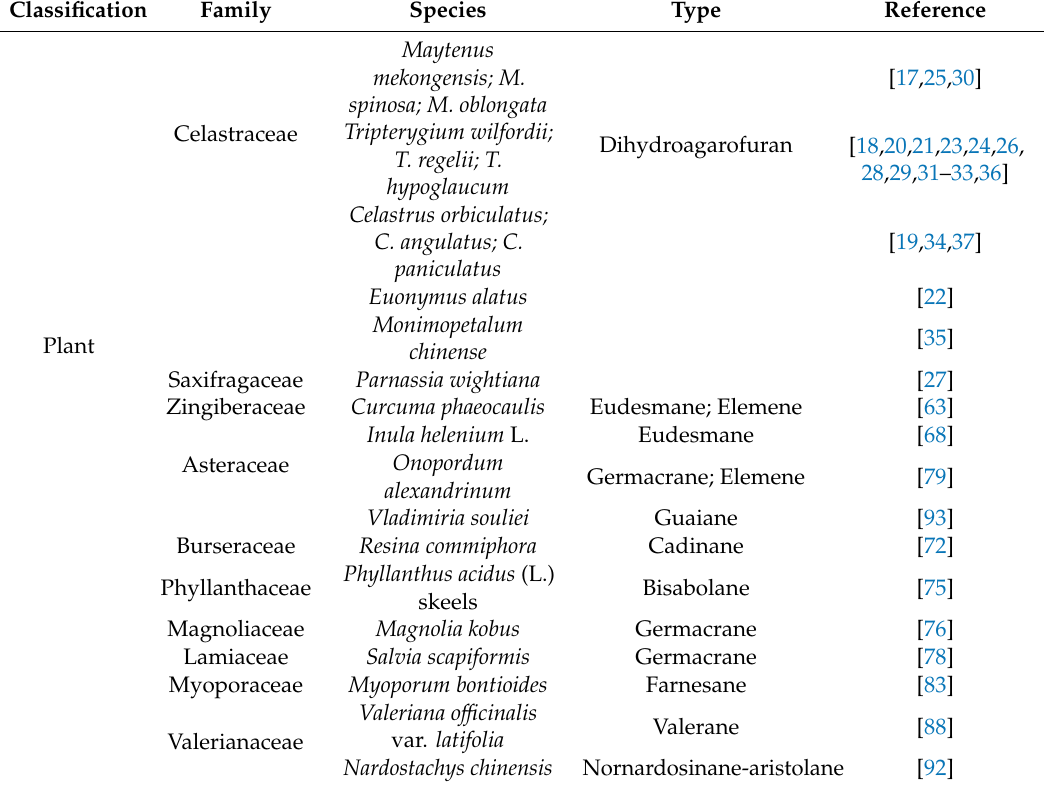
Table 3. The species containing nitrogenous